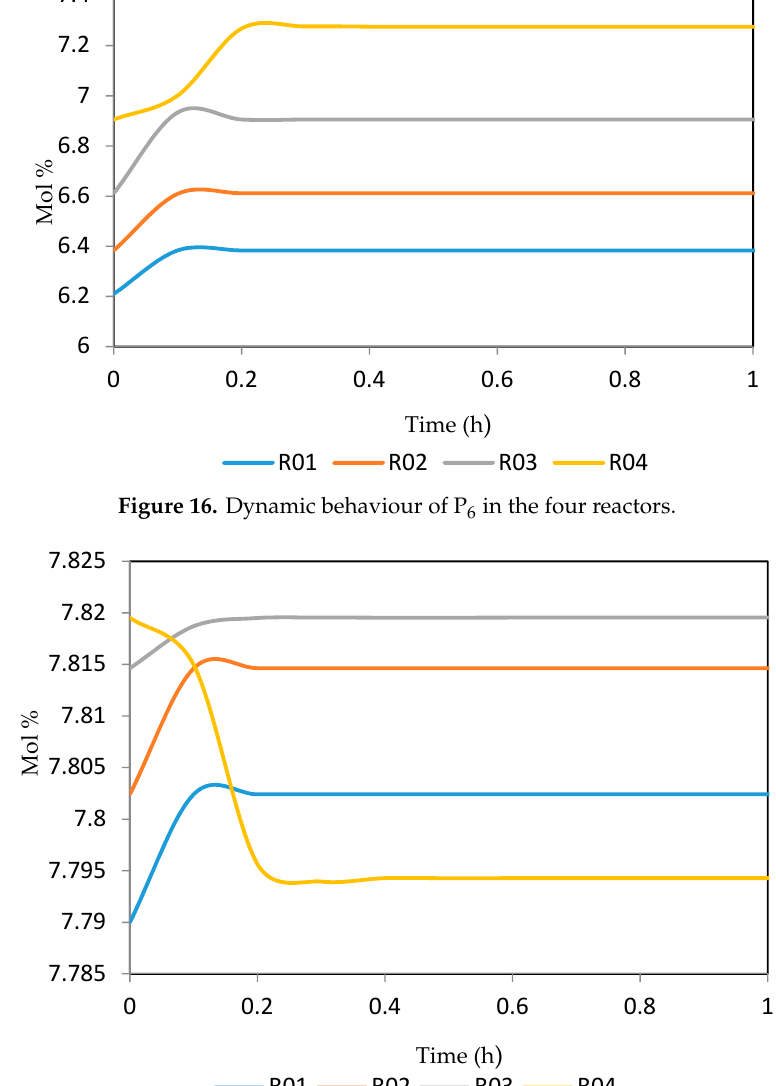
Figure 18. Dynamic behaviour of P 8 in the four reactors.